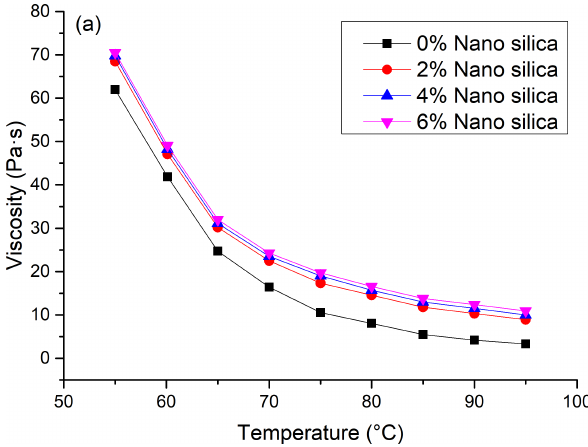
Figure 2: Viscosity-temperature curves for LCM phenolic resin